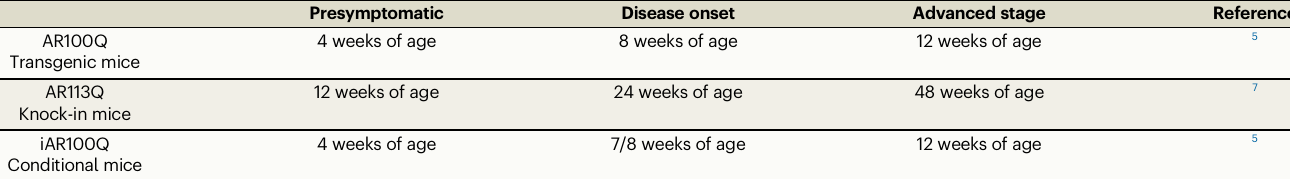
Table 1 | Disease progression in different SBMA mouse models Presymptomatic Disease